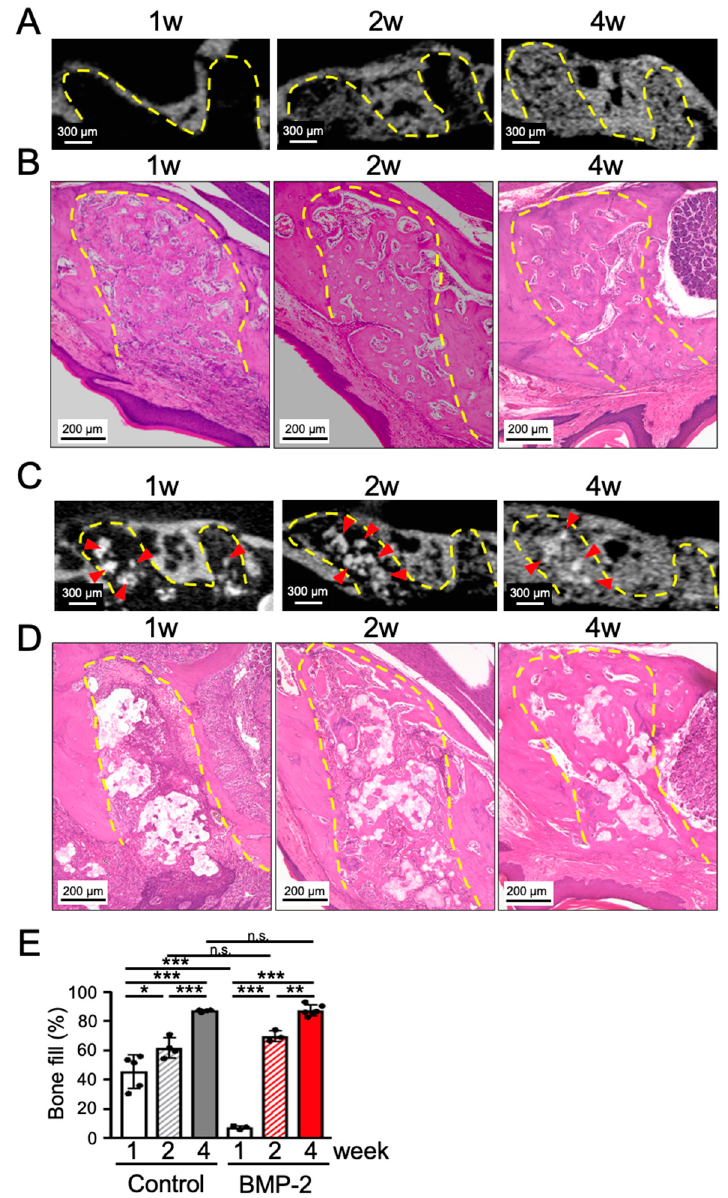
Figure 1. Transplantation of Bone Morphogenetic Protein (BMP)-2/beta-tricalcium phosphate ( β -TCP) does not accelerate bone regeneration in the tooth extraction socket during the normal socket healing process. ( A ) Sagittal images of micro computed tomography micro-CT and ( B ) Hematoxyline and Eosin (HE)-stained sections after 1, 2 and 4 weeks of tooth extraction without any treatment. ( C ) Sagittal images of micro-CT and ( D ) HE-stained sections after 1, 2 and 4 weeks of BMP-2/ β -TCP transplantation into the tooth extraction socket of the maxillary first molar. ( E ) The graph shows the quantitative analysis of the bone-fill rate in the tooth extraction socket. Bars represent the mean values and standard deviation (+/ − SD) ( n = 3–6). (* p < 0.05, ** p < 0.01, *** p < 0.001, ns: no significant difference. Two-way ANOVA/Tukey). Red arrowheads indicate the residual β -TCP. Yellow dashed lines indicate the tooth extraction socket.